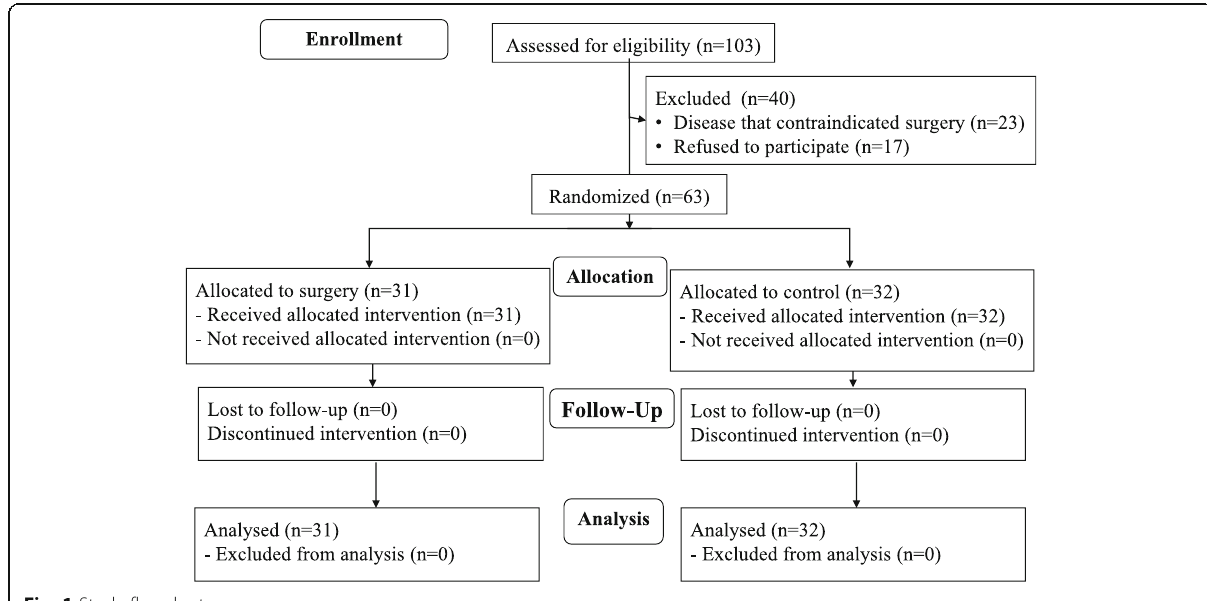
Intervention group ( n =